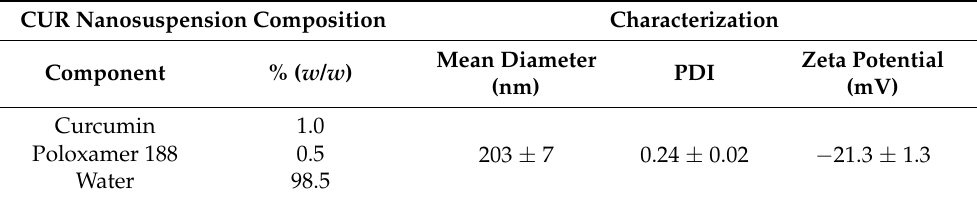
Table 1. Composition and characterization of CUR nanosuspension at the day of preparation. CUR Nanosuspension Composition Characterization